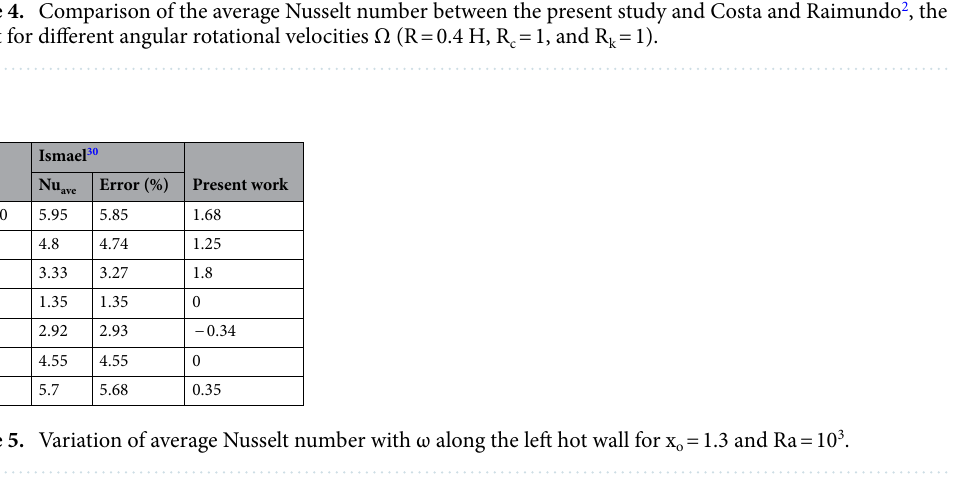
Table 4. Comparison of the average Nusselt number between the present study and Costa and Raimundo 2 , the result for different angular rotational velocities Ω (R = 0.4 H, R c = 1, and R k = 1).